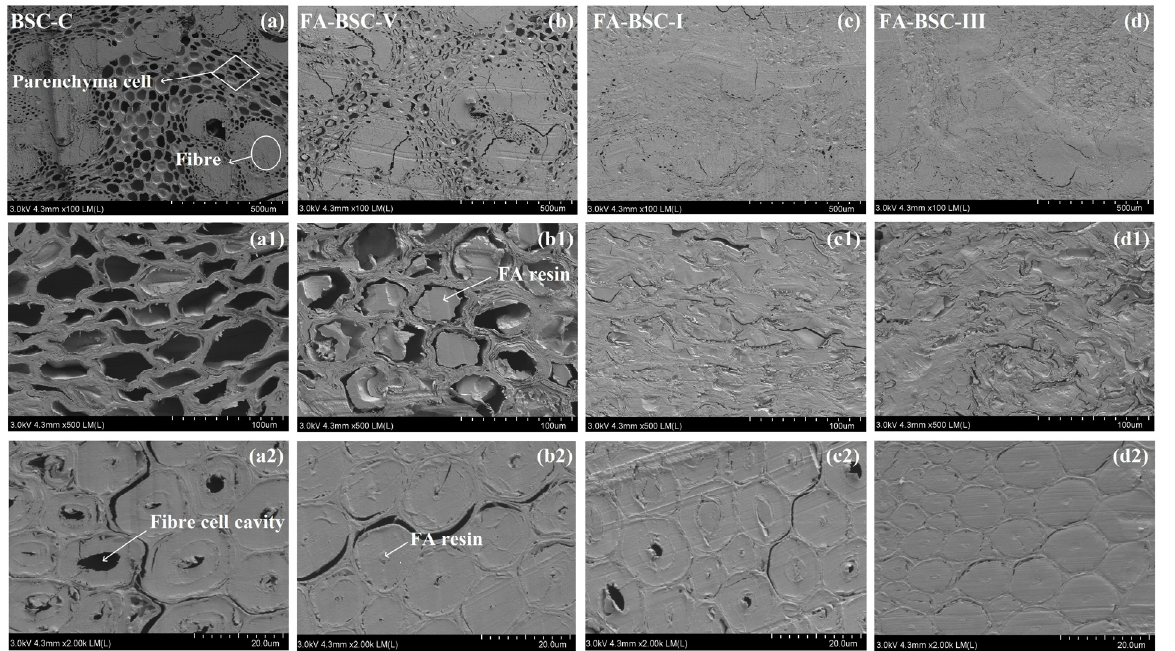
Figure 3. SEM images of untreated and furfurylated BSC cross-sections: ( a , a1 , a2 ) from BSC-C; ( b , b1 , b2 ) from FA-BSC-V; ( c , c1 , c2 ) from FA-BSC-I; ( d , d1 , d2 ) from FA-BSC-III. ( a1 , b1 , c1 , d1 ) Parenchyma cells. ( a2 , b2 , c2 , d2 ) Fiber cells.